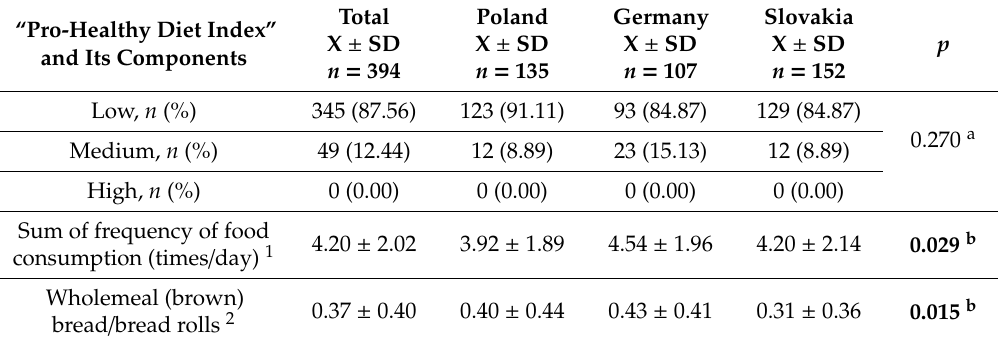
Table 2. Pro-Healthy Diet Index and frequency of consumption of food groups potentially beneficial for health (times /